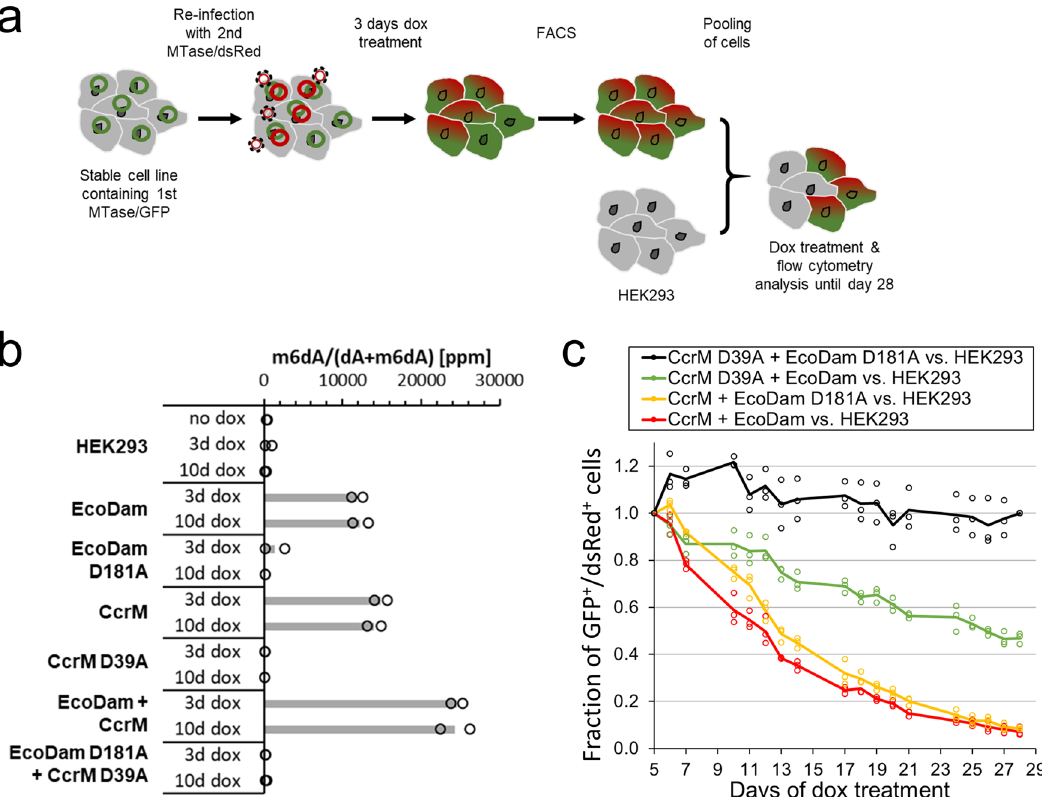
Fig. 2 Co-expression of two N6-MTases leads to increased m6dA levels in the cells. a Schematic depiction of the experimental work fl ow used for the generation of stable double cell lines and the competitive proliferation assay displayed in panel ( c ). b Quanti fi cation of genome-wide m6dA levels relative to the sum of m6dA and dA in parts per million (ppm) by HPLC-MS/MS measurement. Levels were determined for genomic samples with and without expression of different N6-MTases. c Flow cytometry results of the competitive proliferation assay for the cell lines co-expressing two N6-MTases (GFP + /dsRed + ) versus non- fl uorescent HEK293 cells. The fraction of GFP + /dsRed + cells was calculated and normalized to day 5 of dox